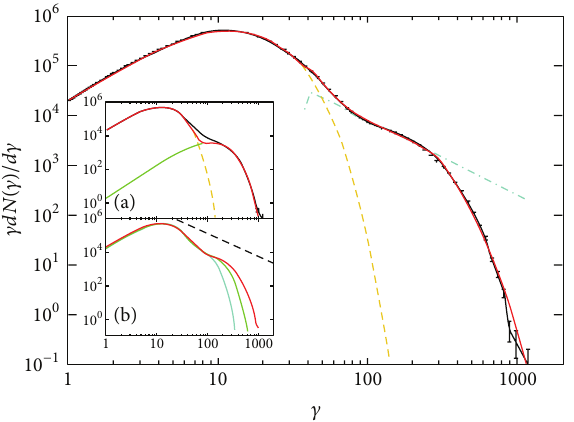
Figure 15: Results of a particle in cell (PIC) simulation shows the particle distribution downstream from the shock (black line). The red line is a fit with a low energy Maxwellian, and a high energy power law, with a high energy exponential cutoff. Subpanel (a) is the fit with a sum of high and low temperature Maxwellians (red line), showing a deficit at intermediate energies; subpanel (b) is the time evolution of a particle spectrum in a downstream slice at three differenttimes.Theblackdashedlineshowsa 𝛾 − 2 . 4 powerlaw.Figure taken from Spitkovsky